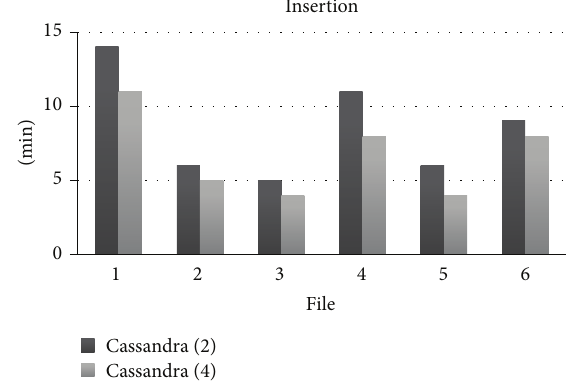
Figure 4: Comparison between inserts (time × file number).